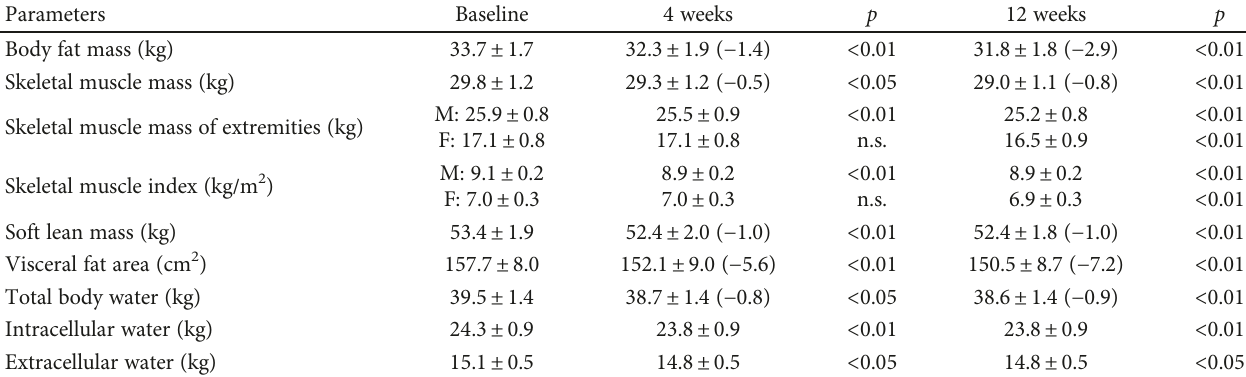
Table 2: Evaluation about the e ffi cacy of tofogli fl ozin on body composition using